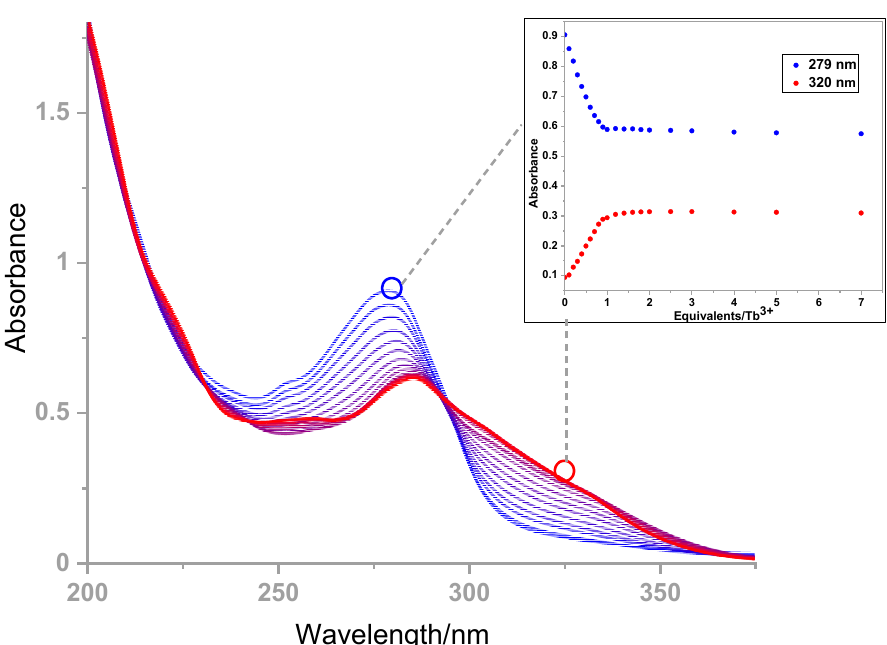
Figure 2. Absorption spectra resulting from the titration of ligand 1 (9.7 µ M, acetonitrile) with 0 to 7 equivalents of Tb(OTf) 3 .